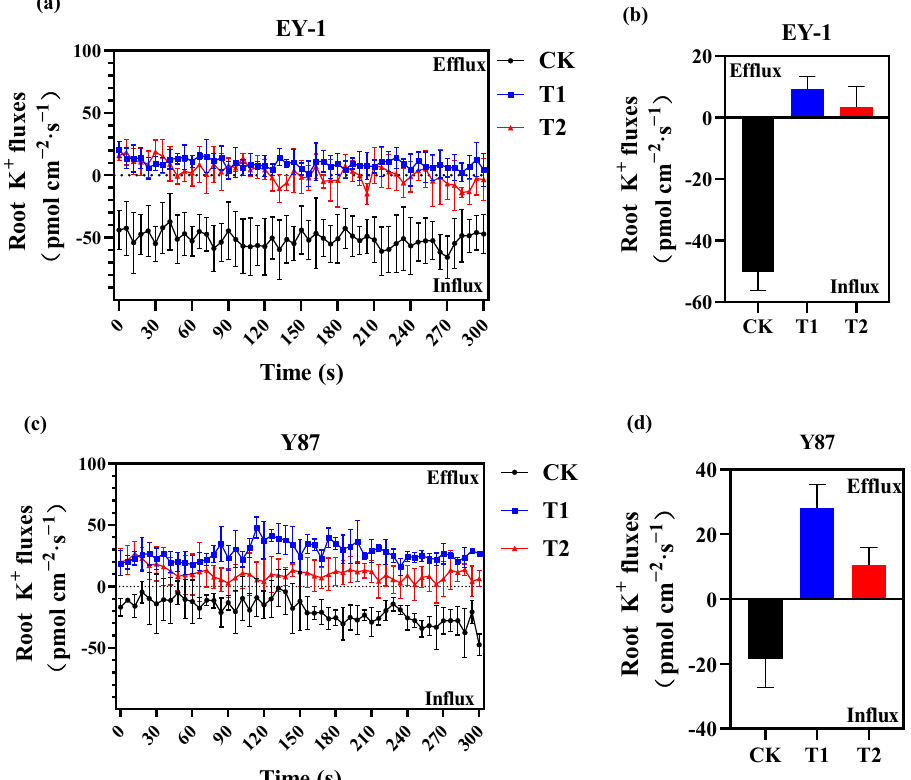
Figure 2. The root K + instantaneous flux of EY-1 ( a ) and Y87 ( c ), and average flux of EY-1 ( b ) and Y87 ( d ) measured in roots. CK, control; T1, topping; T2, IAA application after topping. Each seedling was tested for 300 s, and each treatment had 6 biological replicates. The change of K + flux between the control and the treatment was calculated as mean flux.